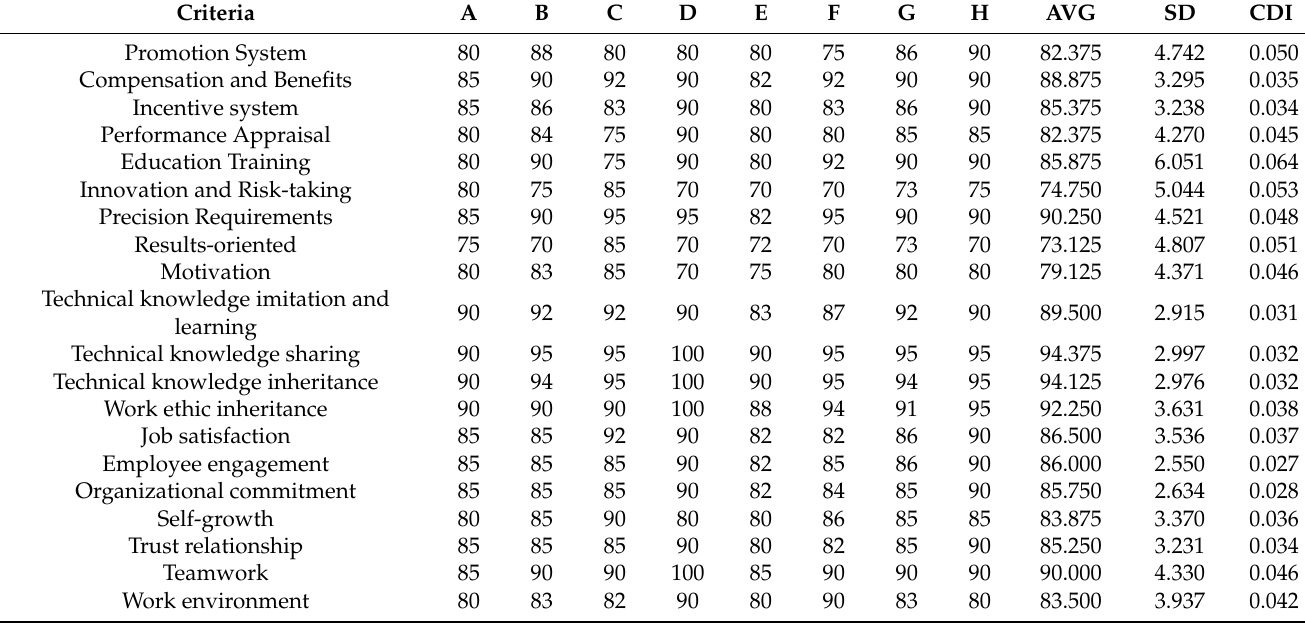
Table A1. Results of the third Delphi questionnaire